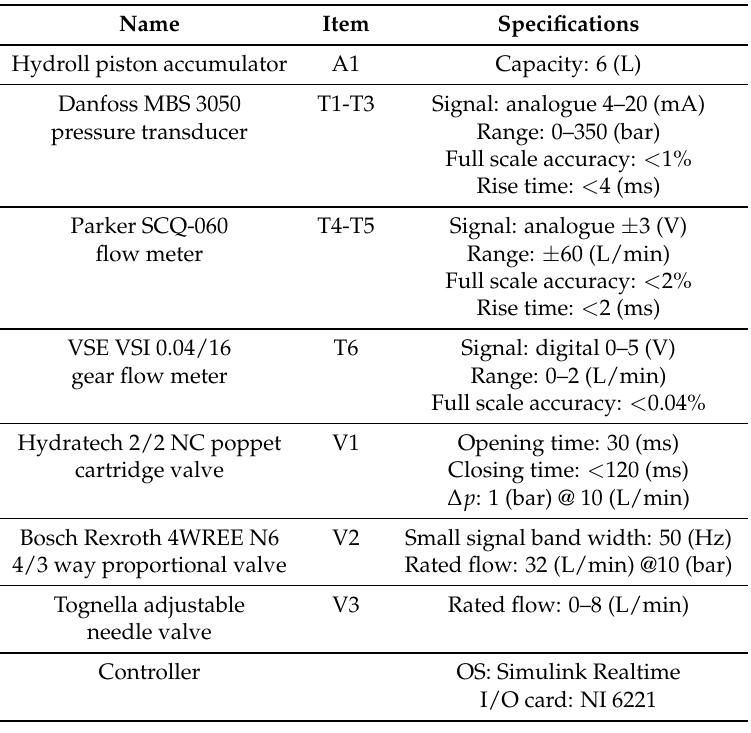
Figure 11. Experimental setup and corresponding hydraulic diagram. Table 4. Main data for the sensors and components used in the experimental